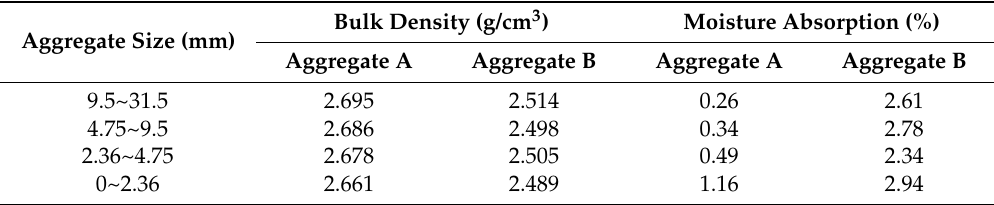
Table 1. Density and moisture absorption of